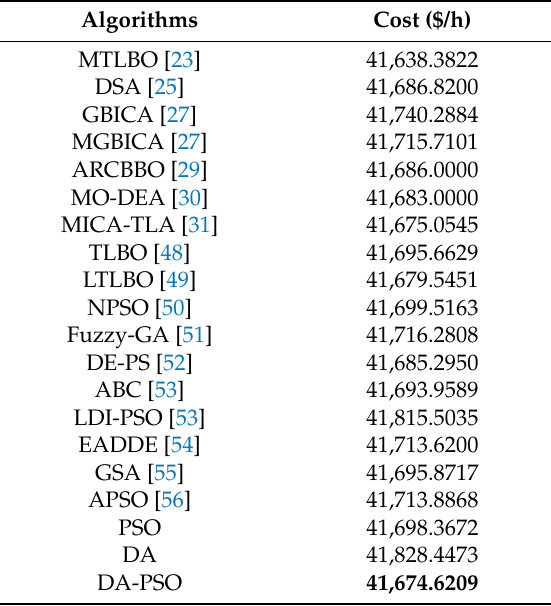
Table 6. Comparison of the results from DA-PSO and other algorithms when considering only fuel cost as part of the objective function for the IEEE 57-bus system.